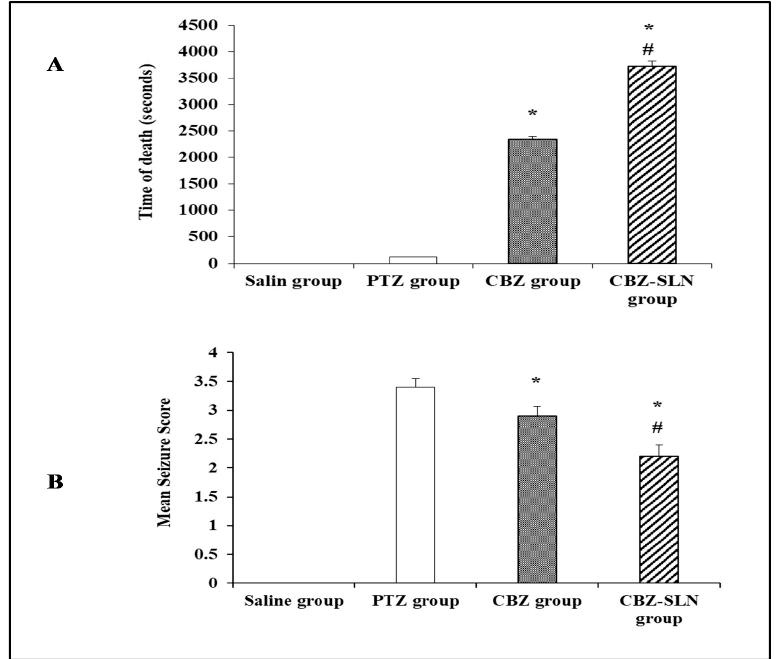
Figure 7. The pharmacological activity of carbamazepine solid lipid nanoparticles; ( A ) the e ff ect of free carbamazepine and carbamazepine solid lipid nanoparticles (F8) on the time to death after the administration of a lethal dose of pentylenetetrazole (PTZ), and ( B ) the e ff ect of free carbamazepine and carbamazepine solid lipid nanoparticles (F8) on mean seizure scores in pentylenetetrazole (PTZ)-kindled mice. Data are presented as mean ± SD (n = 6) and were analyzed using an ANOVA followed by Bonferroni’s post hoc test at p < 0.05. * Compared to the PTZ group, # compared to the CBZ